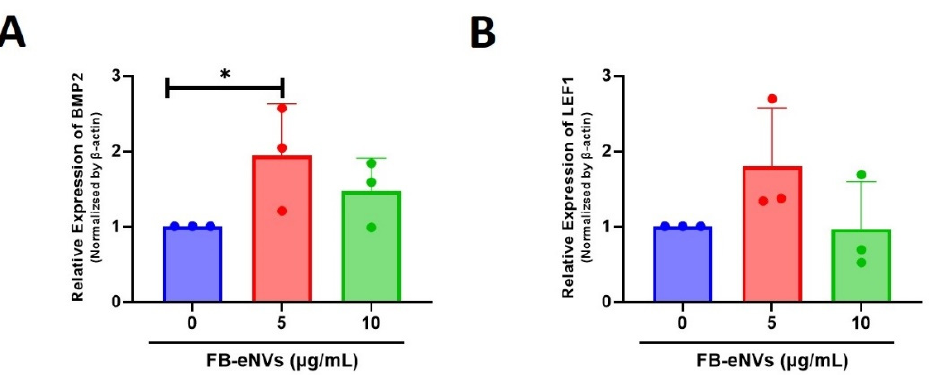
Figure 5. FB-eNV treatment modulated the mRNA expression in DP cells. ( A , B ) Relative mRNA expression of BMP2 and LEF1 in DP cells, 24 h after FB-eNV (5 and 10 µ g/mL) treatment; β -actin was used as an internal control. The values are mean ± sd of a minimum of three replicates of an experiment. Student’s t -test was used. * p < 0.05.